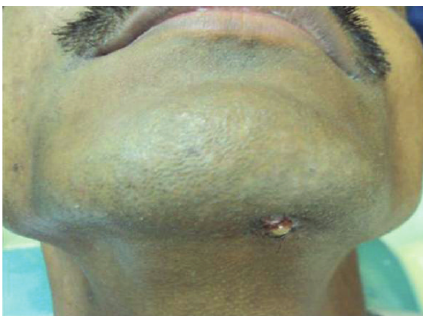
Figure 1: Nonhealing extraoral sinus in the submental region.